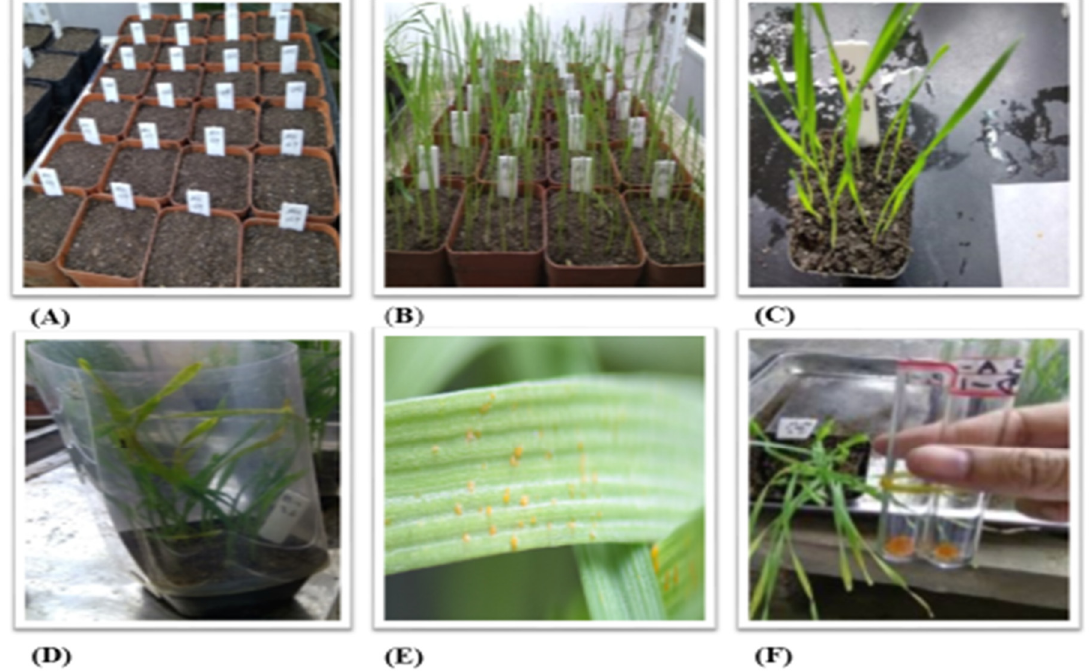
Figure 3. ( A ) Isolation and multiplication of urediniospores of PST and ( B ) growing of wheat seedlings of susceptible wheat variety “Mingxian 169”. ( C , D ) Inoculation of 10-day-old wheat seedlings covered with plastic cylinder, ( E ) appearance of urediniospores 10 days after inoculation (dai), and ( F ) collection of urediniospores in glass